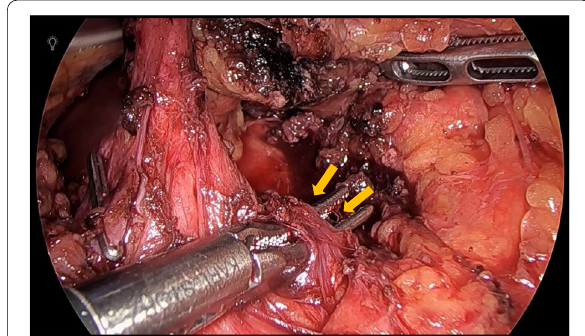
Fig. 4 Laparoscopic findings. A fibrous connective tissue was found on the anterior aspect of celiac artery, which was confirmed as the MAL